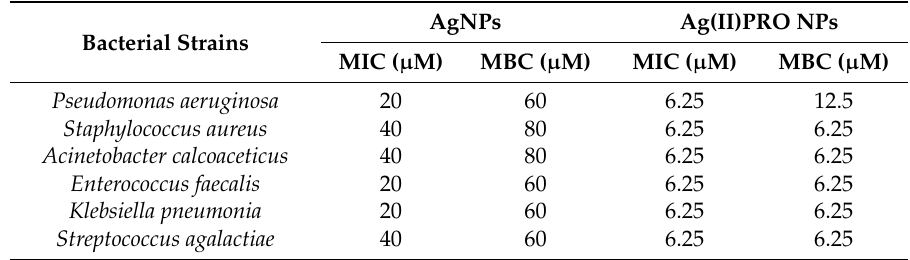
Table 1. MICs (minimal inhibitory concentrations) and MBCs (minimum bacterial concentrations) of